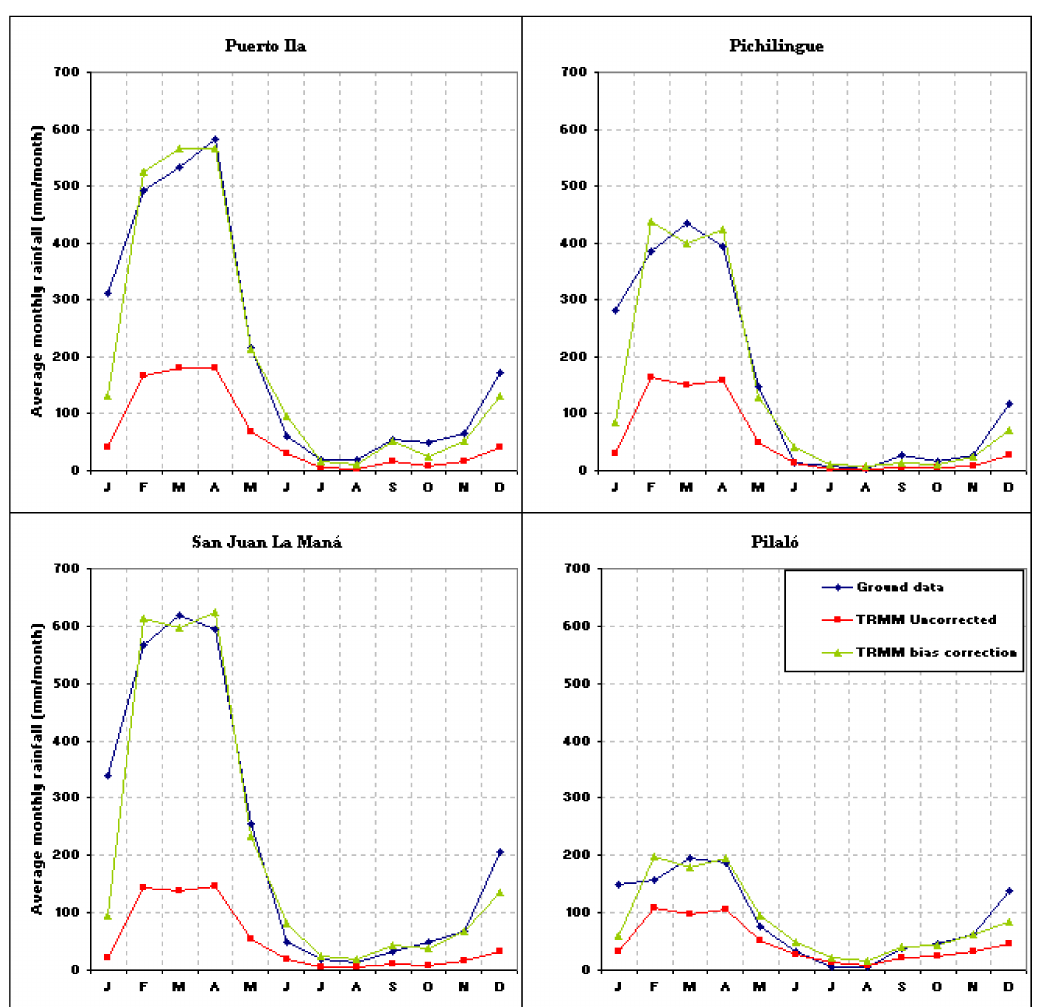
Fig. 4. Average monthly bias-corrected TRMM (TMPA-3B42R) data over 1999–2006 compared with rain gauges and uncorrected satellite- borne